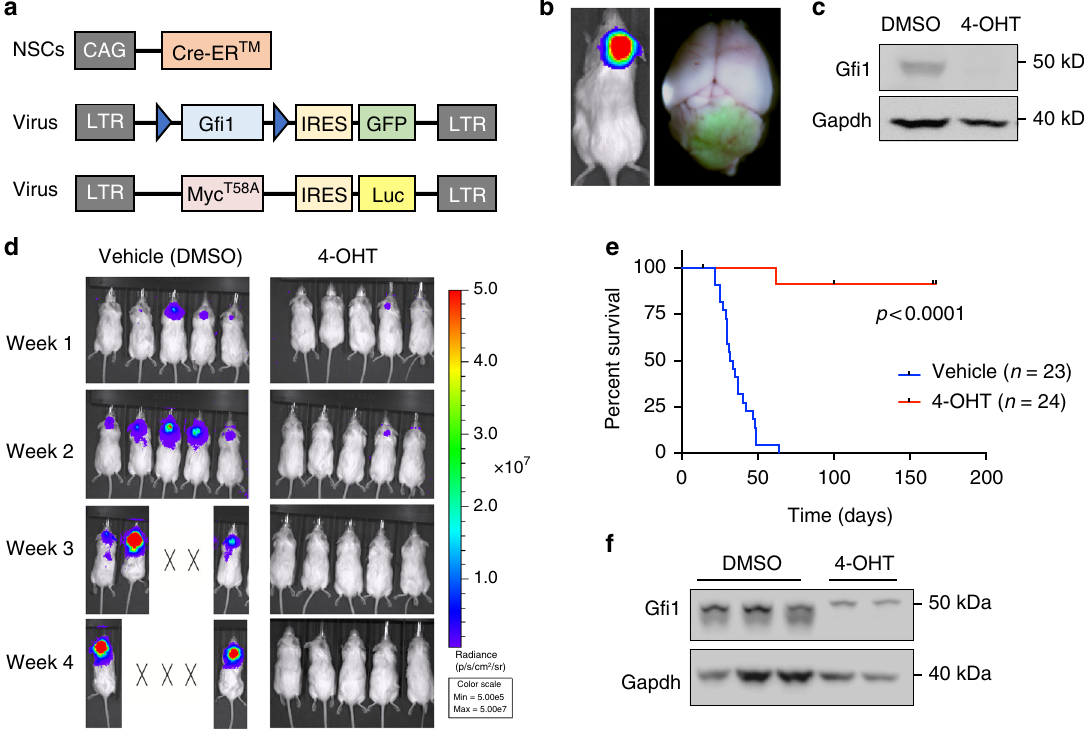
Fig. 1 G fi 1 is required for tumor maintenance. a Constructs used to generate MG fl ox tumors. NSCs from a CAG-CreER TM mouse were transduced with viruses encoding G fi 1 fl ox -IRES-GFP and Myc T58A -IRES-Luciferase. b Bioluminescence imaging and whole mount fl uorescence image of representative MG fl ox tumor. c Western blot for G fi 1 protein in MG fl ox tumor cells treated overnight with vehicle control (DMSO) or 5 µ M 4-hydroxytamoxifen (4-OHT). d Bioluminescence imaging of mice transplanted with cells treated with vehicle or 4-OHT. X ’ s denote animals euthanized before they could be imaged. e Survival curves from a representative experiment (control n = 23, 4-OHT n = 24). p Value< 0.0001 was determined by Log-rank (Mantel – Cox) test. f Western blot of G fi 1 protein in resulting MG tumors from vehicle and 4-OHT treatment